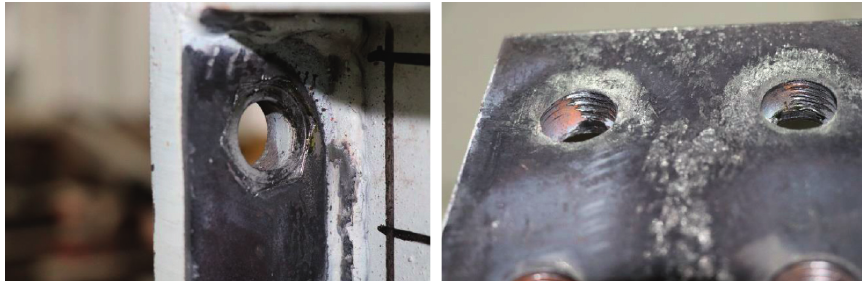
Figure 26: Strain of bolts in specimen PDKB-1.